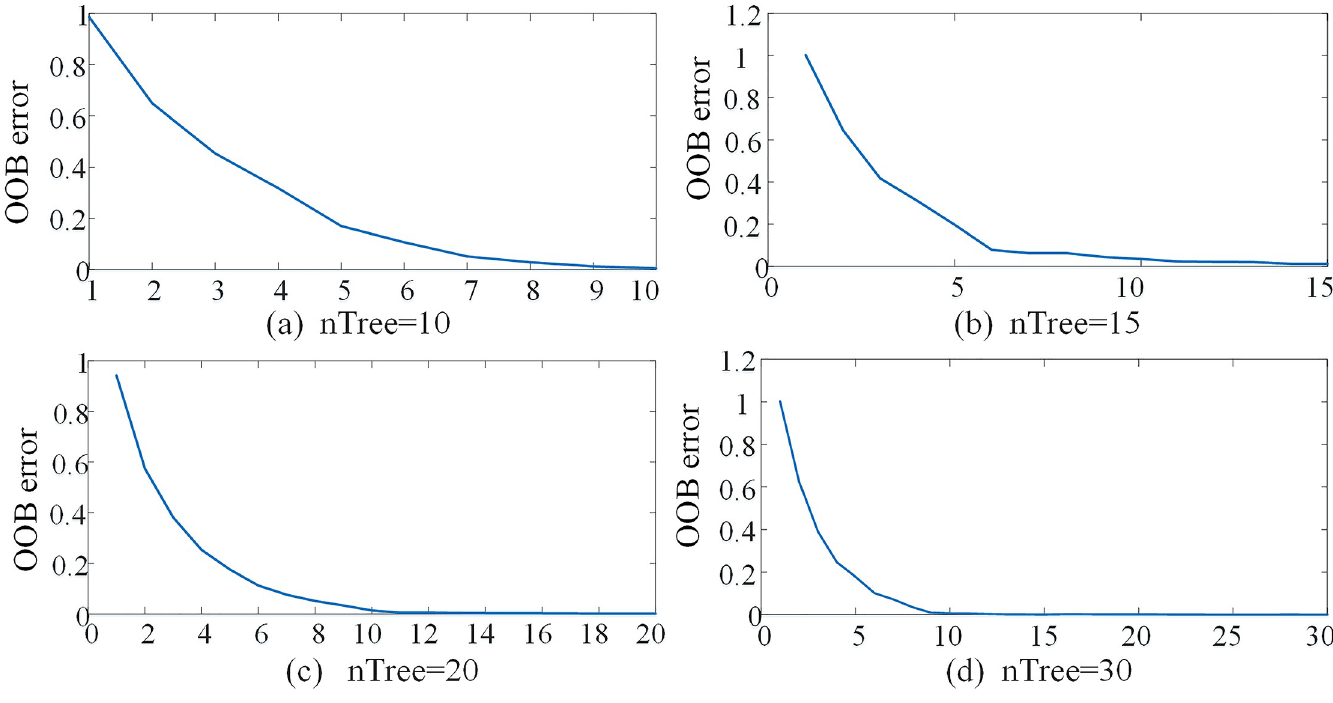
Fig 12. OOB error